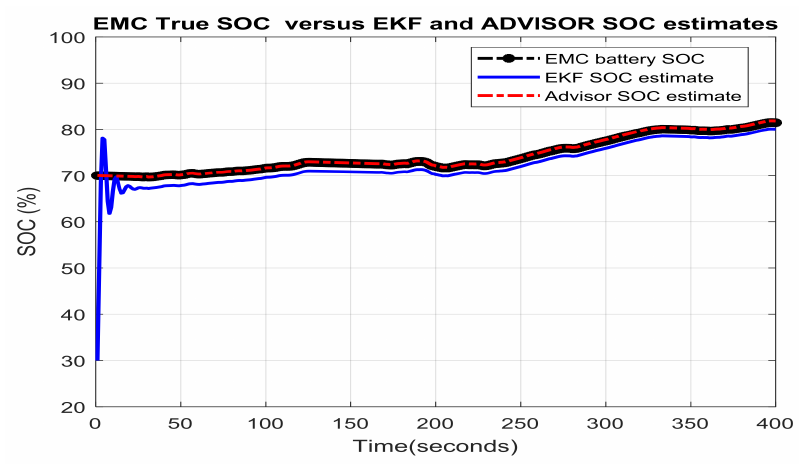
Figure 26. The 3RC EMC SOC model versus EKF SOC and ADVISOR SOC estimates for T = 20 ◦